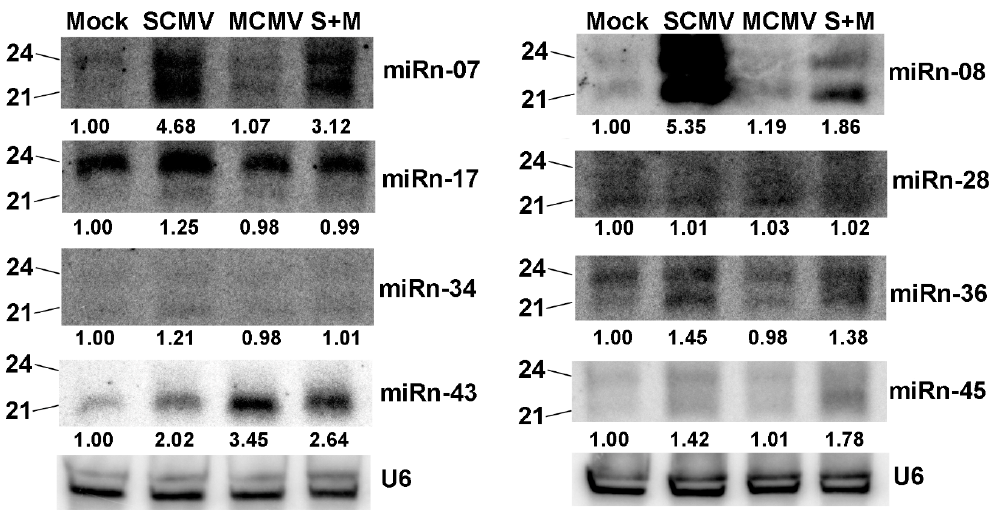
Figure 4. The expression of several novel miRNAs in Mock-, SCMV-, MCMV-, and S + M-inoculated maize plants. The accumulation of small RNAs was detected at 9 dpi by Northern blotting. The samples from three independent experiments with at least three biological replicates each were pooled for RNA extraction. U6 was used as a loading control. The expression levels of small RNAs from Mock-inoculated plants (negative controls) were set to a value of 1.00 as reference, and those from SCMV-, MCMV-, or S + M-inoculated maize plants were counted relative to the levels of Mock-inoculated maize plants from the same experiments using the Image J software.